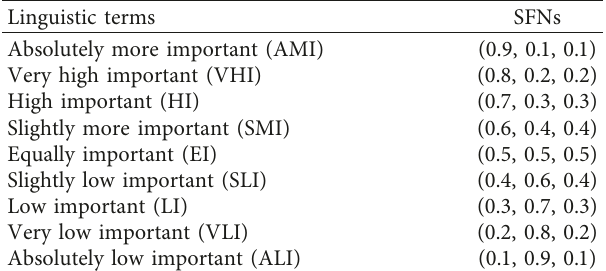
grounding on integrated ABC-VED implementation results, “Damaged/delinquent delivery” criterion was found to have